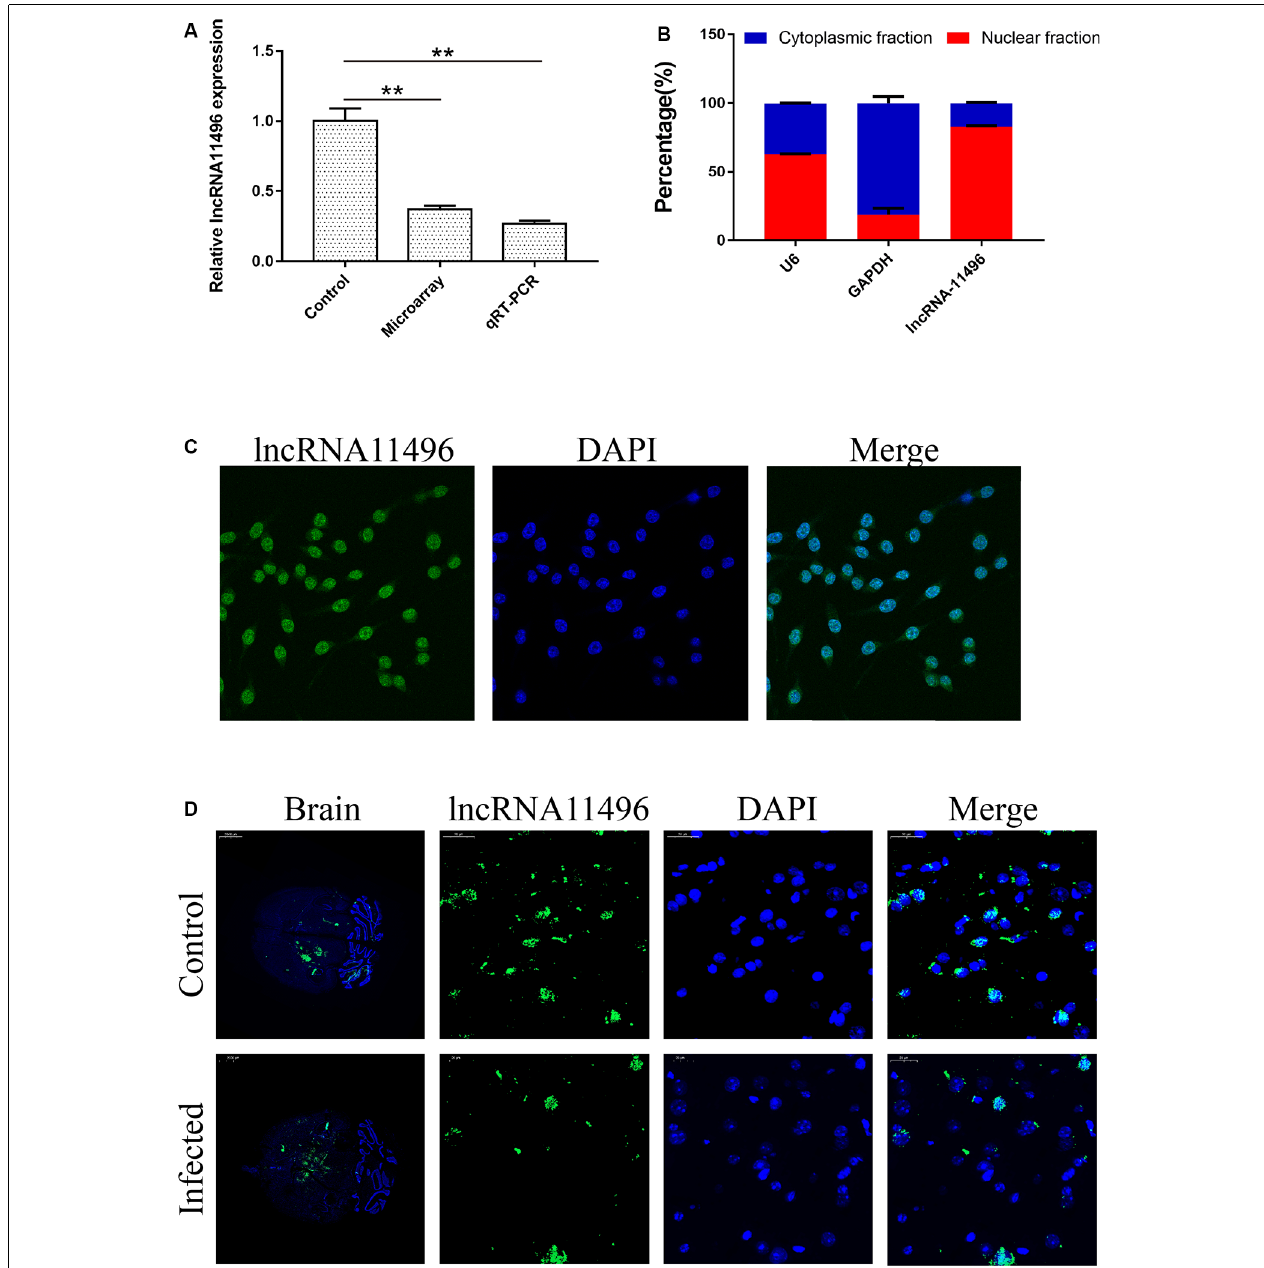
FIGURE 3 | Validation of lncRNA-11496 down-regulation in chronic T. gondii infected mouse brain. (A) Validation of the expression of lncRNA-11496 by microassay and quantitative real-time PCR (qRT-PCR). All values are presented as mean ± SD for three independent experiments. ** P < 0.01, student’s t -test. (B) A majority of lncRNA-11496 was expressed in the nucleus of BV-2 cells through cellular fraction assays. U6 served as a positive control for nuclear gene expression and GAPDH served as a positive control for cytoplasmic gene expression. (C) Fluorescence in situ hybridization (FISH) analysis demonstrated that lncRNA-11496 was distributed mostly in the nucleus of BV-2 cells. (D) FISH binding affinity of lncRNA11496 shows a significant down regulation trend in the brain of T. gondii infected mice compared with that of the uninfected